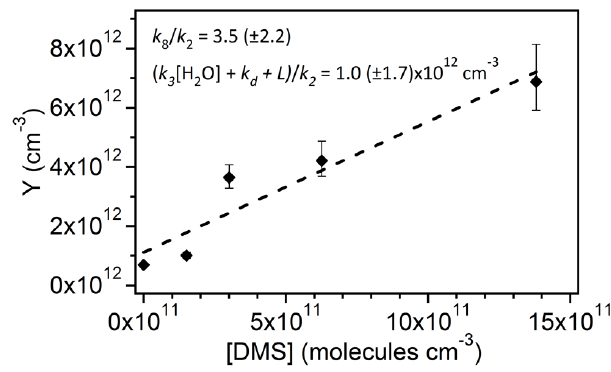
Figure 6. Application of Eq. (8) to derive rate constants for reaction of ISOP-SCI with DMS ( k 8 ) relative to that for reaction with SO 2